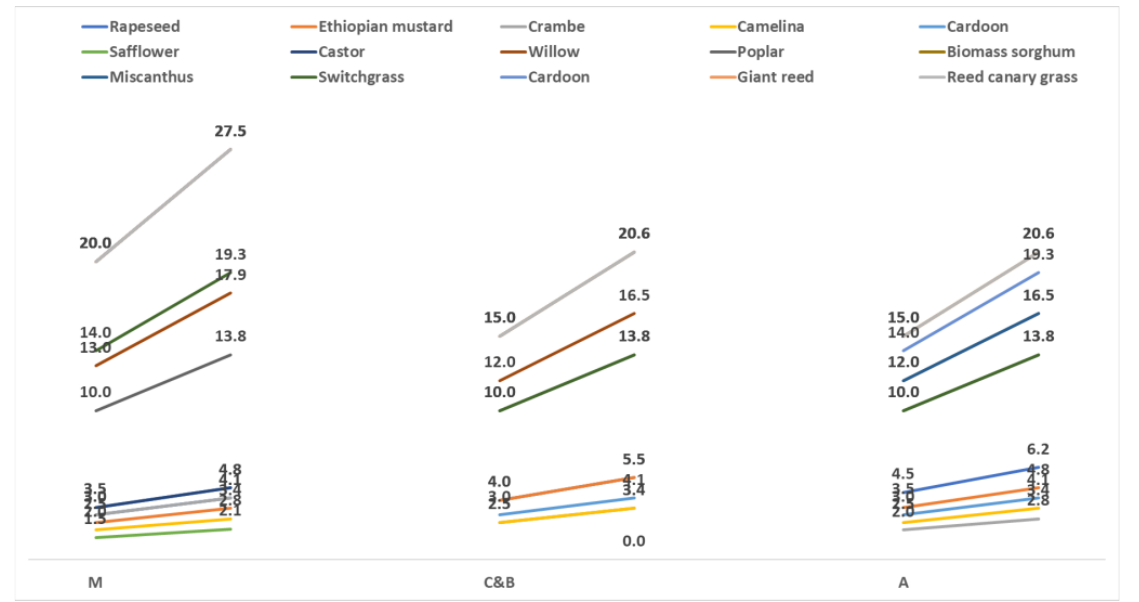
Figure 2. Estimated yield increases from the sustainable agricultural practices in farming land in the three AEZ. Details in Annex I (Tables A1 and A2). Table 3. Technology biomass crops, relevant advanced biofuel types, agronomic suitability for